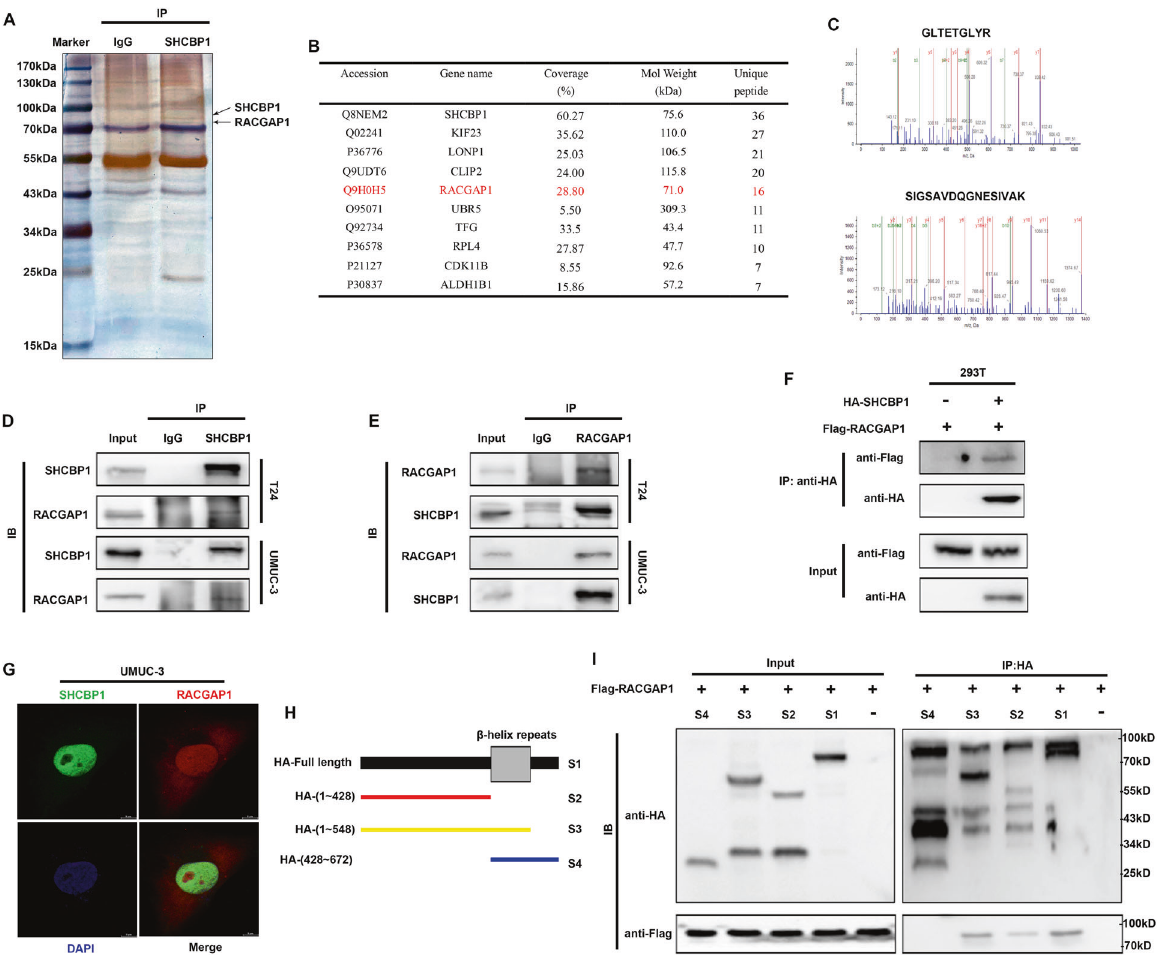
spectrometry, and the top ten interacting partners are shown. C The peptide map of the protein band marked by the arrow is identi fi ed as RACGAP1. D , E The endogenous interaction between SHCBP1 and RACGAP1 was detected by coimmunoprecipitation and immunoblotting in T24 and UMUC-3 cells. F The exogenous interaction between HA-SHCBP1 and Flag-RACGAP1 was assessed by coimmunoprecipitation and immunoblotting in 293 T cells. G Confocal fl uorescence microscopy observing the colocalization of SHCBP1 and RACGAP1 in UMUC-3 cells. H , I Immunoprecipitation and immunoblotting analysis indicated that the N-terminal amino acid sequence (1 ~ 428) of SHCBP1 speci fi cally interacted with